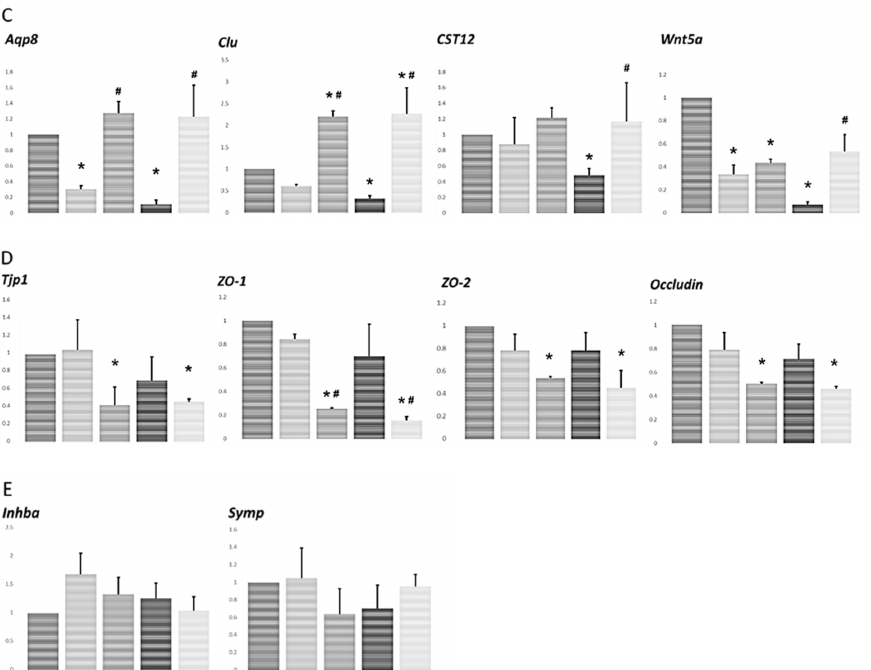
Figure 3. The levels of 27 mRNA transcripts encoding markers of Sertoli cell-specific products in each group. Expression was measured by real-time RT PCR, and the results are expressed relative to the internal control GAPDH, expressed as the mean ± SD of five mice in each group. The y-axis shows relative mRNA intensity. ( A ) Transcripts showing a significant decrease in levels after irradiation treatment compared to control values. ( B ) Transcripts showing a significant increase in levels after irradiation treatment compared to control values. ( C ) Transcripts showing a significant decrease in levels only in group I but not group II compared to control values. ( D ) Transcripts showing a significant decrease in levels only in group II but not group I compared to control values. ( E ) Transcripts showing no change in levels after irradiation treatment compared to control values. * P < 0.05 vs. control group; # P < 0.05 vs. group I.